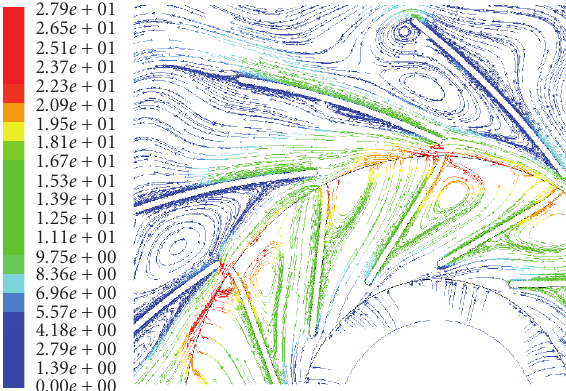
Figure 6: Relative velocity plot for configuration A (radial gap ratio = 0.05).